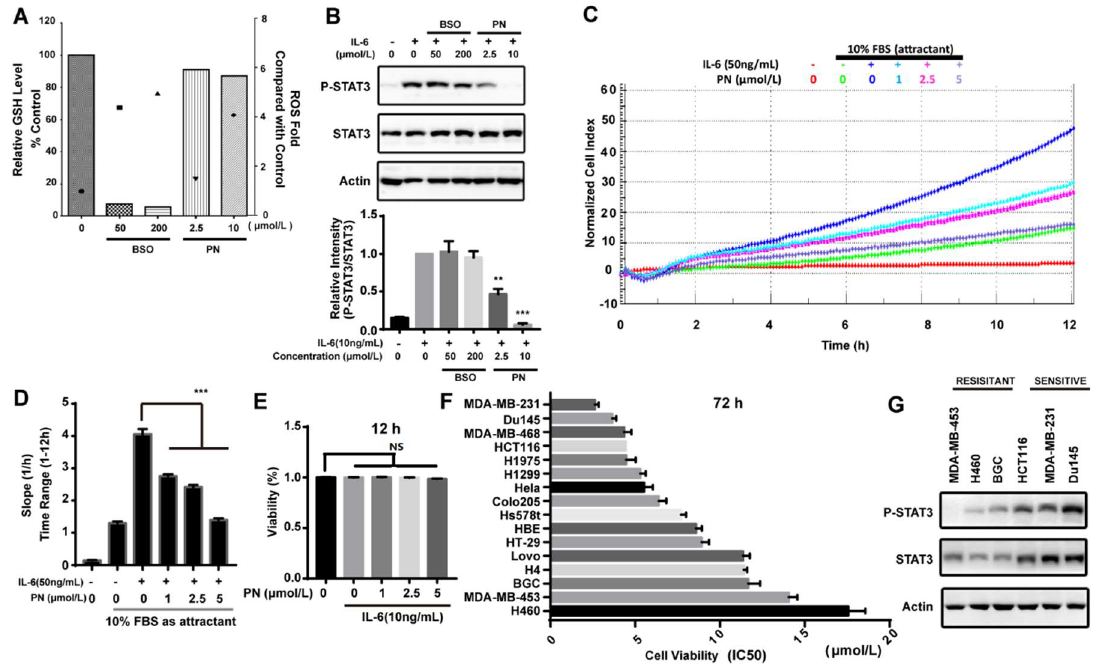
Figure 5. ROS did not participate in the inhibition of STAT3 phosphorylation and parthenolide inhibited the migration and growth of cancer cells. ( A ) The effects of BSO and PN on the cellular GSH and ROS level. MDA-MB-231 cells were treated with BSO for 24 h or with PN for 30 min. Cellular GSH level (histogram) and ROS level (scattergram) were determined as described in Material and Methods. ( B ) The effects of BSO and PN on IL-6-induced STAT3 phosphorylation. MDA-MB-231 cells were treated with BSO for 24 h or with PN for 30 min before stimulation by IL-6 for 10 min. Cell lysates were processed for Western blot analysis. ( C ) Parthenolide inhibited IL-6-induced cancer cell migration. MDA-MB-231 cells were seeded in serum-free medium in the upper chamber. 10% FBS was added in the lower chamber. Cells were then treated with PN. The migration was monitored by real-time cell analysis system for 12 h. ( D ) The migration rate was quantified by RTCA software 2.0. ( E ) The effect of PN on cell viability. Cells were treated with PN for 12 h. The effect on cell viability was determined by alamar blue assay. ( F ) IC50 of PN on growth of different human cancer cell lines. Cells were incubated with PN for 72 h. The drug effect on cell growth was determined by MTT assay. IC50 (means ± SD, n = 3). ( G ) The expression and phosphorylation of STAT3 in the sensitive and resistant cancer cells. Cells were lysed and analyzed by Western blot. ( n = 3, NS = no statistical difference, ** p < 0.001, *** p < 0.001, One-way ANOVA).